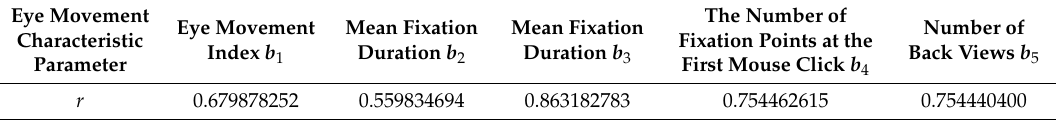
Table 8. Correlation between each eye movement characteristic parameter and cognitive